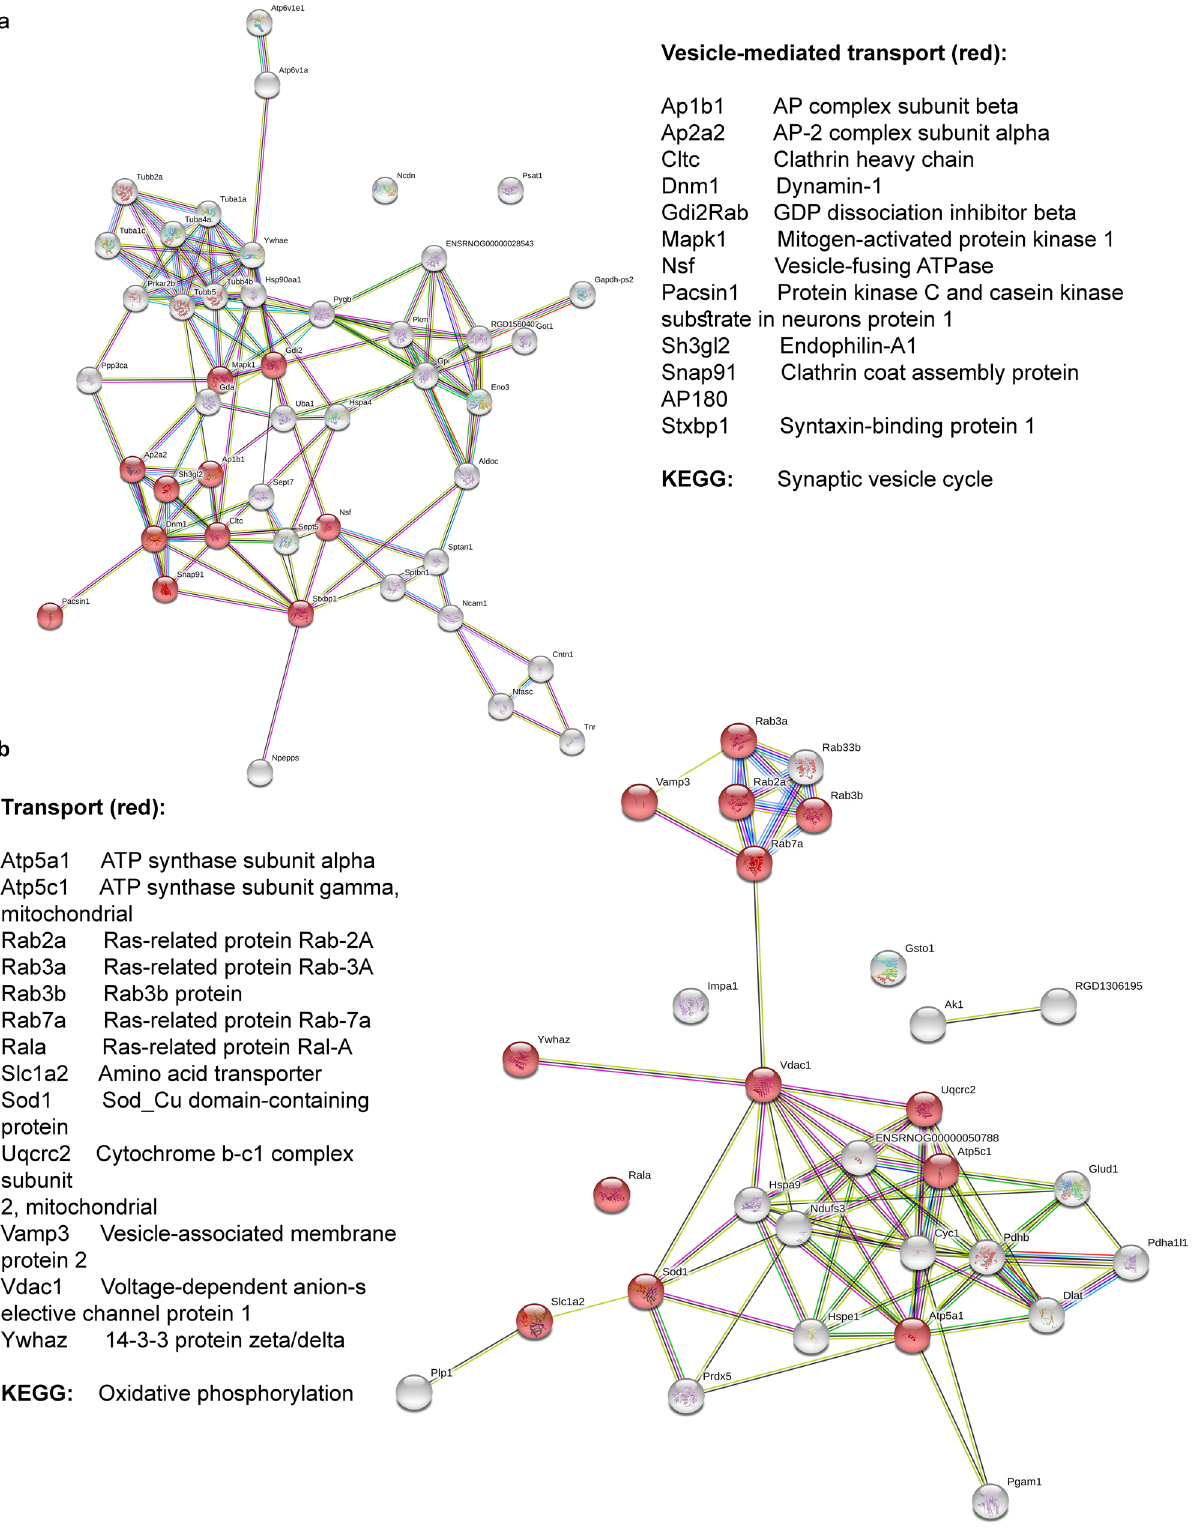
Figure 4. STRING-based interactome map of interactions among differently regulated proteins in Tian-treated CSIS rats, with the corresponding GO Biological process terms: ( a ) up-regulated synaptosomal proteins and ( b ) down-regulated synaptosomal